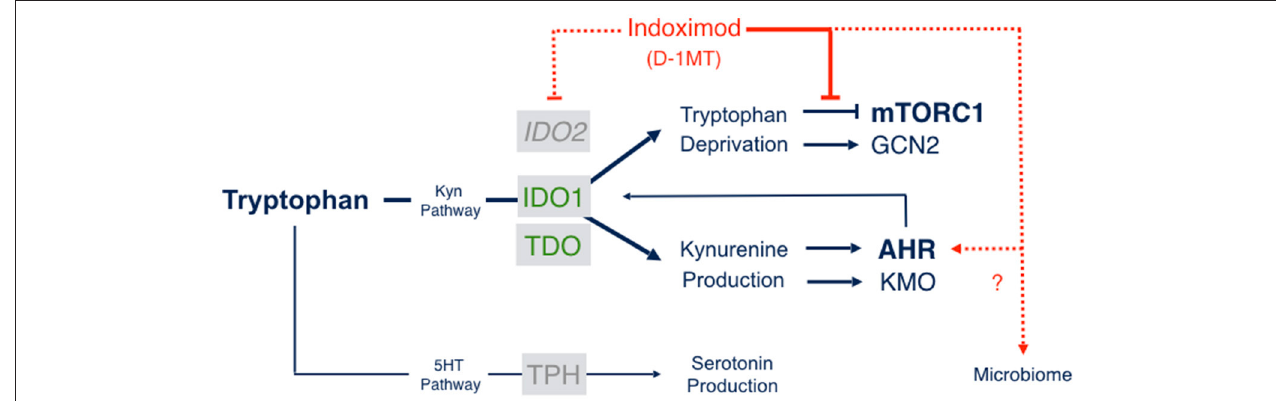
FIGURE 2 | Indoximod mechanisms of action . Tryptophan catabolism proceeds through pathways leading to serotonin or NAD production, the latter through the kynurenine pathway which handles ∼ 95% of Trp catabolism in mammals. Indoximod is a Trp mimetic which mTORC1 interprets as L-Trp under conditions of high Trp catabolism and autophagy. Thus, the drug acts to block the suppressive signal on mTORC1 function generated by IDO/TDO activity. Other suggested mechanisms of action include an indirect suppression of IDO2 activity; a modulation of kynurenine-regulated AHR function, which may also influence feedback on IDO1 expression and activity; and an influence on gut microbial physiology influencing systemic immunity (see the